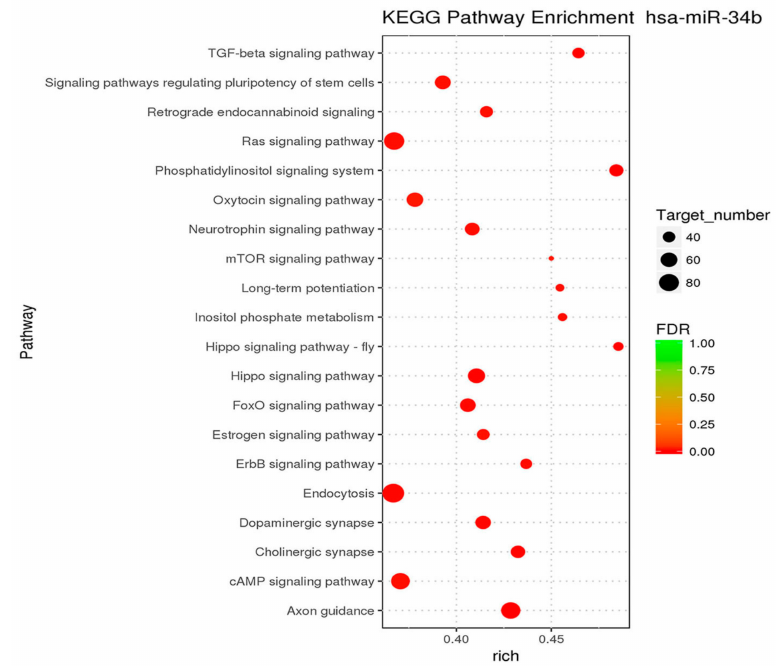
Figure 9. Kyoto Encyclopedia of Genes and Genomes (KEGG) enrichment analysis indicating the pathways affected by miR-34b in prostate cancer cells. The size of the dots indicates the number of differential genes in the pathway, whereas colors represent the significant p -value of the pathway. The 20 most significantly different pathways are